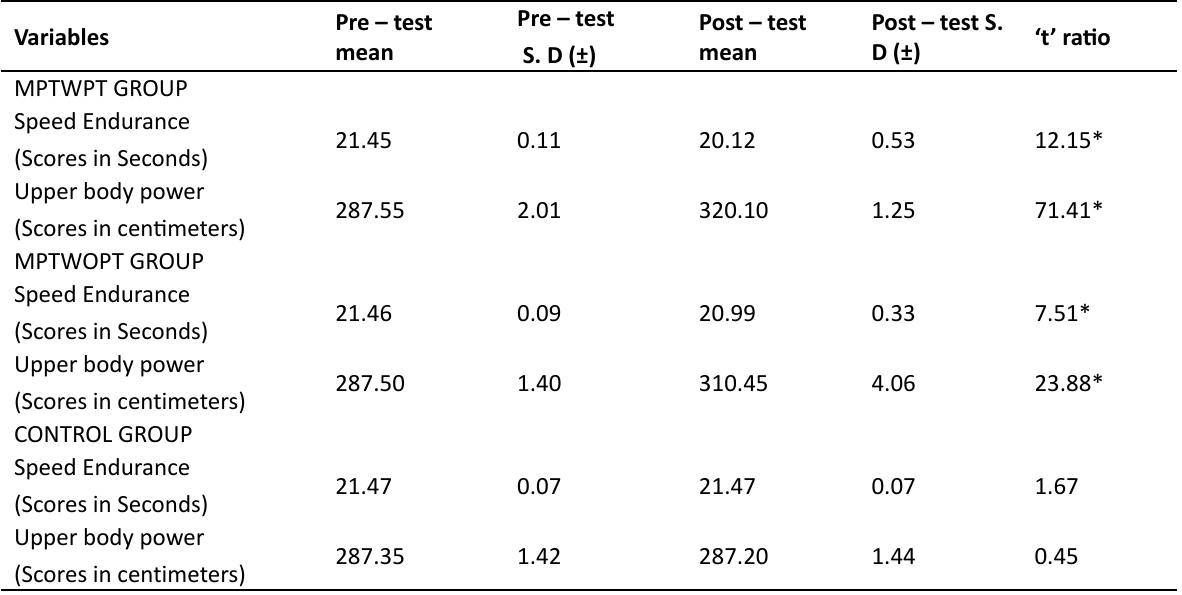
Table 1. Computation of ‘t’ ratio on speed endurance and upper body power of men team handball players Variables